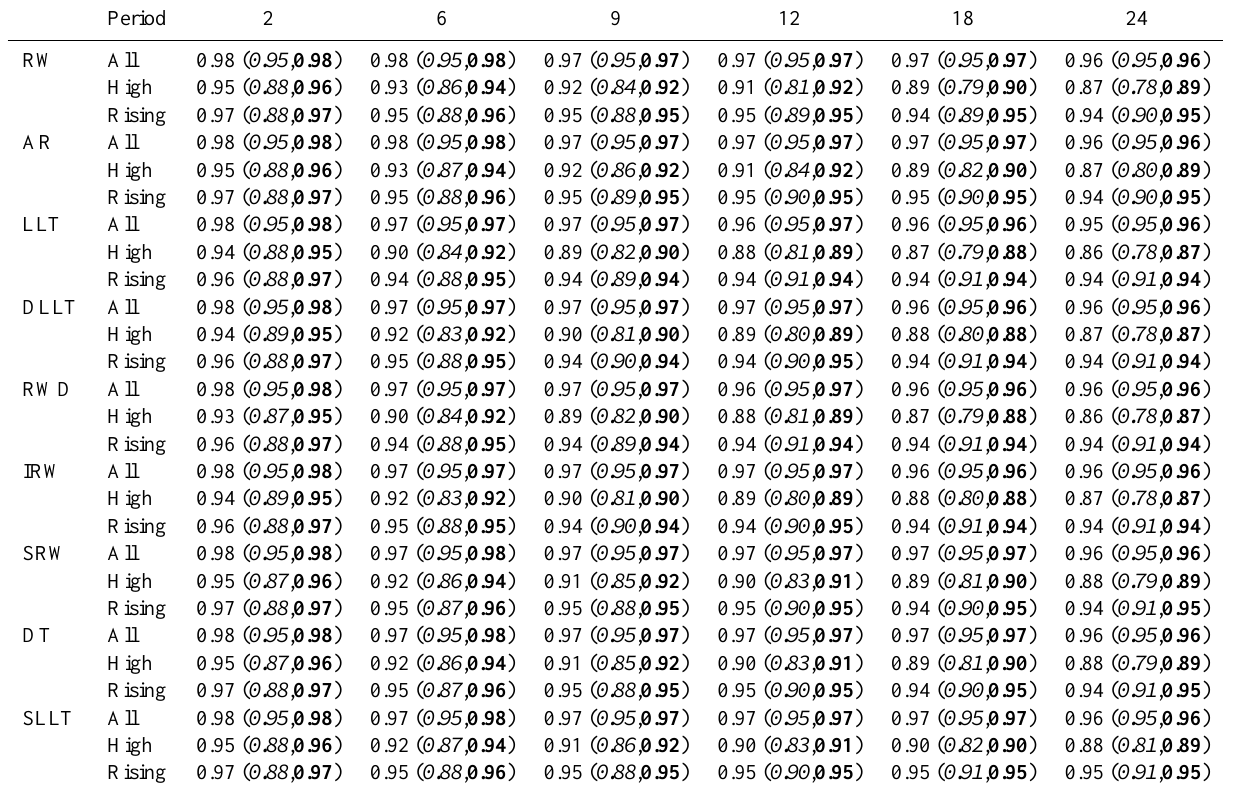
Table 3. Fraction of observations at Welsh bridge bracketed by the estimated 95% prediction intervals during calibration. Bracketed results are those for the SEFE calibration with the italicised and bold values corresponding to the empirical and theoretical symmetric bounds. Results are shown for all the time periods, high levels ( > 2m) and periods where the hydrograph is rising for different combinations of lead time (hours) and GRW